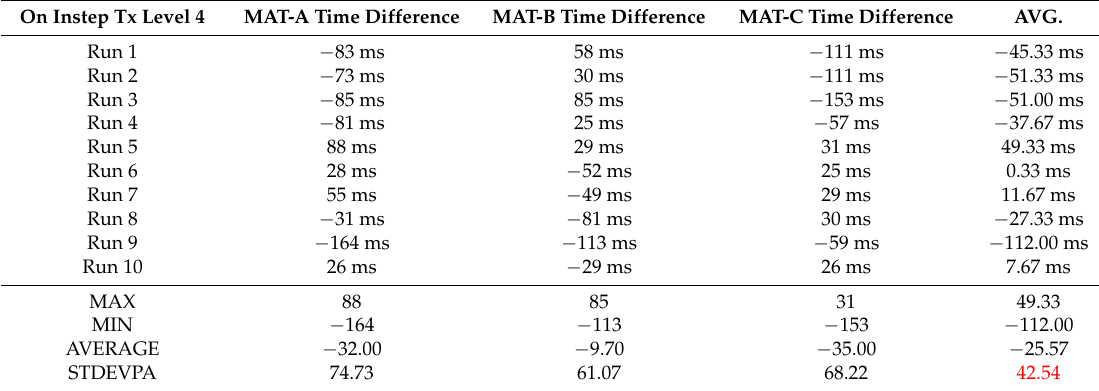
Table 12. The dynamic experiment of three sets of MAT when the BLE Tag is on the runner’s instep.